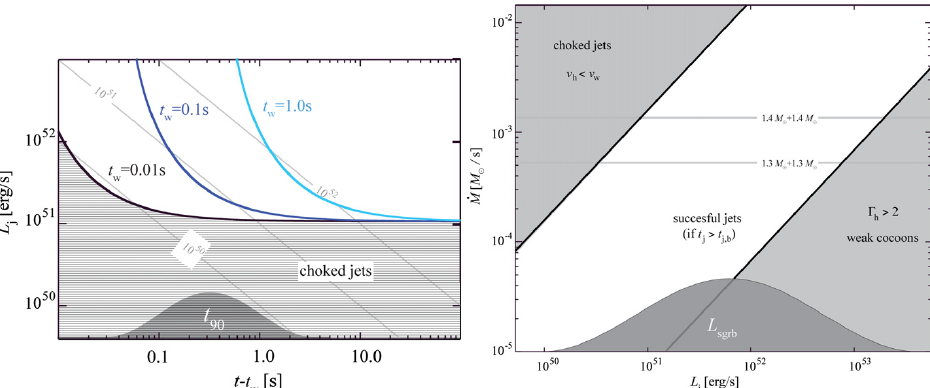
Figure 10. The left panel shows luminosity versus time, where t w is the lifetime of the neutrino wind and the time that the jet begins to expand. The coloured lines indicate a model from [193], that has a wind injection rate of ˙ M w ∼ 10 − 3 M (cid:12) s − 1 with a velocity of 0.3 c . Each line indicate a different termination time t w ∼ 0.01, 0.1, 1 s. For such a heavy wind, the luminosity of the jet has to be above 10 51 erg s − 1 and operate for at least the same time as the wind. (Reprinted from [193]. c (cid:13) AAS. Reproduced with